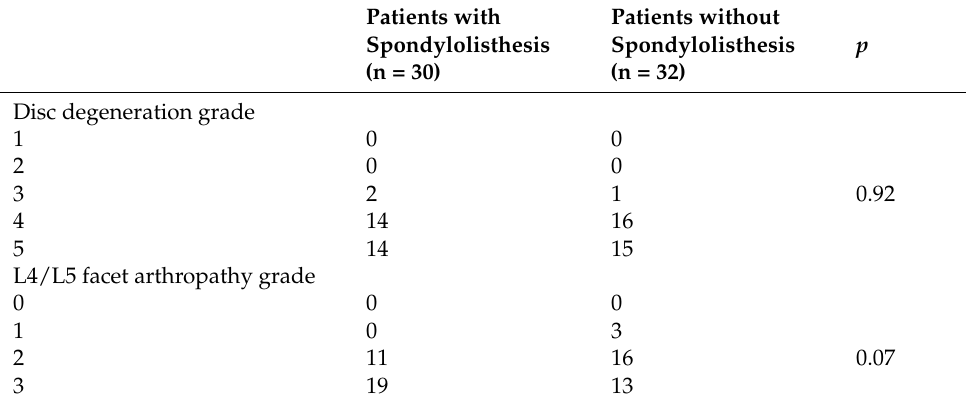
Table 3. Radiologic features of 62 patients.